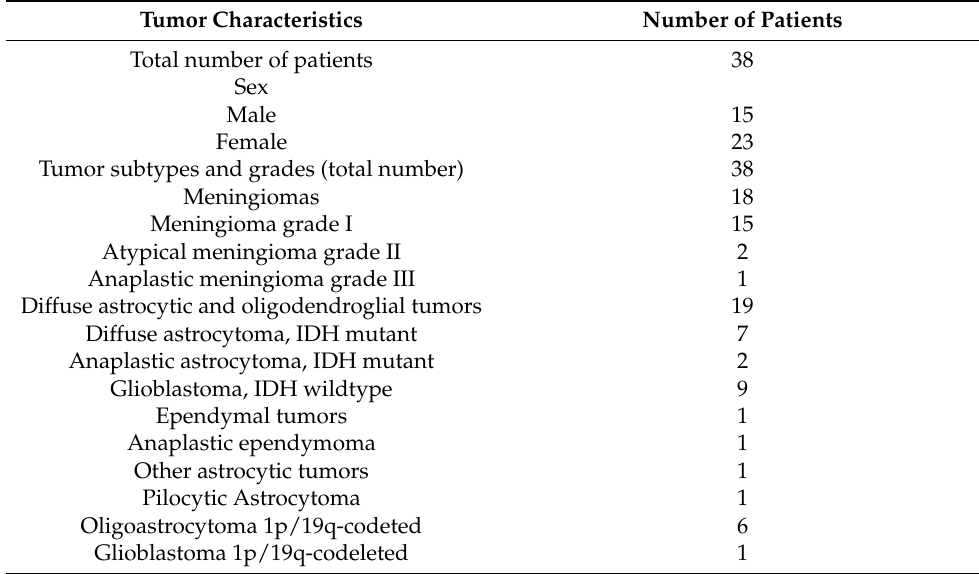
Table 1. Characteristics of patients participated in the